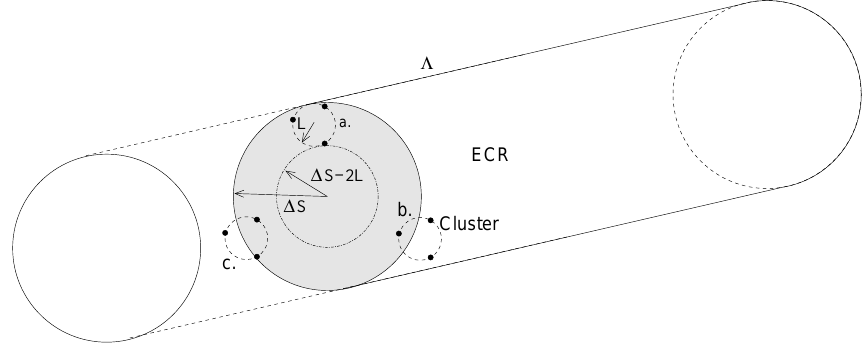
Fig. 5. Sketch of the overlap between a cylindrical ECR and the Cluster spacecraft. A cross-section of the ECR, containing three examples of overlapping spacecraft, is highlighted in grey. The radius of the ECR cylinder is 1S . L is the characteristic size of the Cluster tetrahedron. A statistical investigation of overlaps between ECRs and Cluster are used for obtaining an estimate of the typical perpendicular scale size, 1S , of the ECRs cylindrical cross-section. The cylinder length along the axial direction, 3 , is probably much